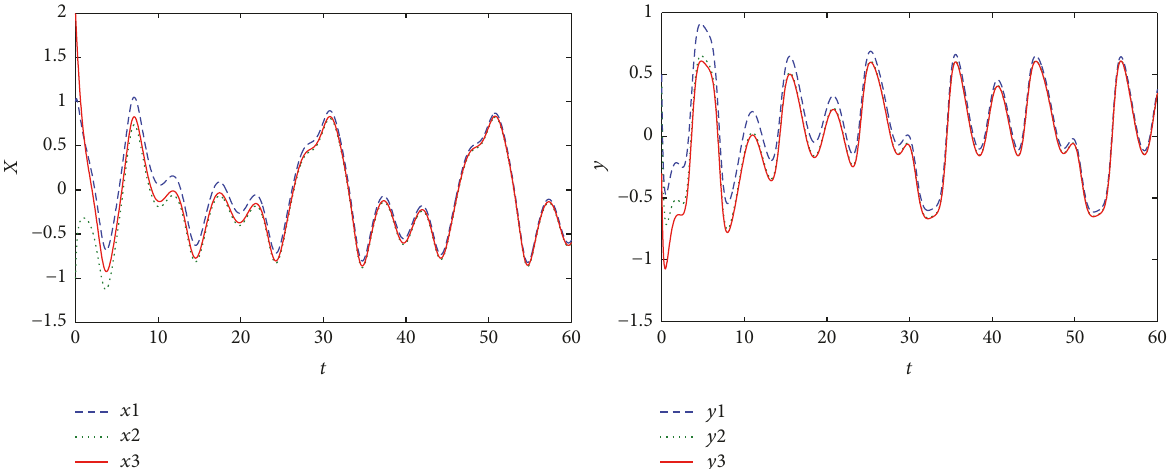
Figure 3: Complete synchronization of three Duffing systems for initial points (𝑥 1,0 ,𝑦 1,0 ) = (1,0.5) , (𝑥 2,0 ,𝑦 2,0 ) = (−1,0.4) , and (𝑥 3,0 , 𝑦 3,0 ) = (2,−0.3) and parameters 𝑎 = 0.2 , 𝑏 = 0.35 , 𝑐 = 0.3 , and 𝑑 = 0.2 .